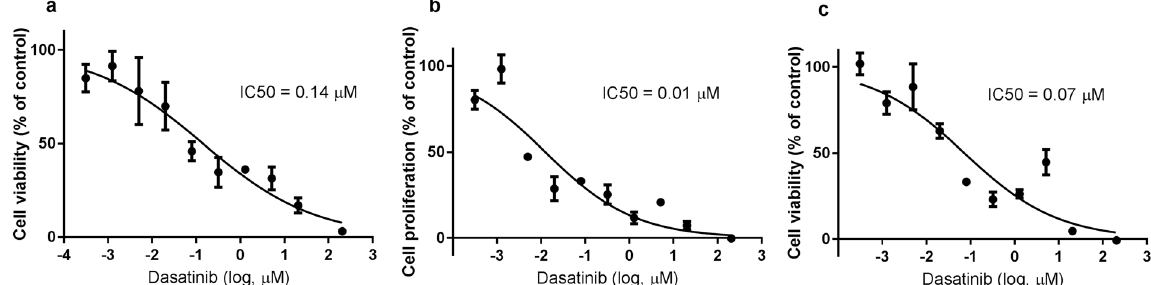
Figure 6. Dasatinib inhibits cell proliferation in MRMT1- luc2 cells in a dose-dependent manner in vitro . MRMT1- luc2 cells were treated with increasing concentrations of dasitanib for 48 h and assayed by the ( a ) MTT assay, ( b ) the BrdU assay, and ( c ) the RealTime-Glo ™ assay. IC50, the concentration needed to inhibit viability or proliferation by 50. Data were normalized to cells treated with 0.1% DMSO (negative controls, 100% activity) and blank controls, e.g. wells without cells (0% activity) and expressed as percentage of these controls. Data are displayed as mean ± SEM. Normalized response is compared to common log of dasatinib concentration ( µ M) and the IC50 calculated using a variable slope. Data from the MTT assay represents one of three independent experiments done in quadruplicates. Data from the BrDU and RealTime-Glo ™ assays represents one experiment done in triplicates to confirm the results from the MTT assay.